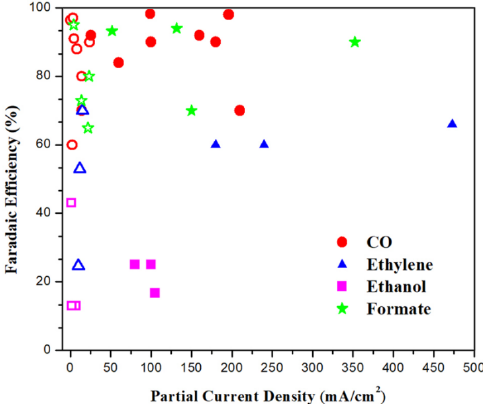
Figure 3. Summary of CO 2 R performance using aqueous-fed [65–84] (empty symbols) and gas-fed [64,85–99] (full symbols) electrolysers. Faradaic efficiencies and their corresponding partial current densities are presented for various catalytic systems converting CO 2 to carbon monoxide, ethylene, ethanol, or formate. The data have been collected from papers published during the last